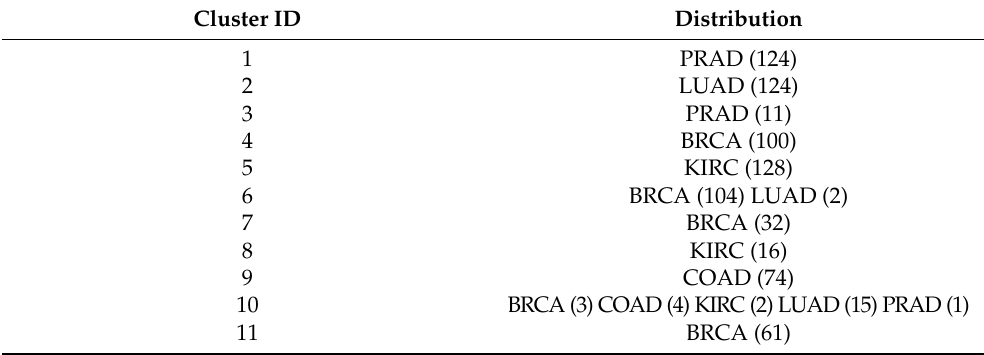
Table 2. The distribution of the EPA cluster assignments. The number in parenthesis is the number of subjects for one of the five cancer types.